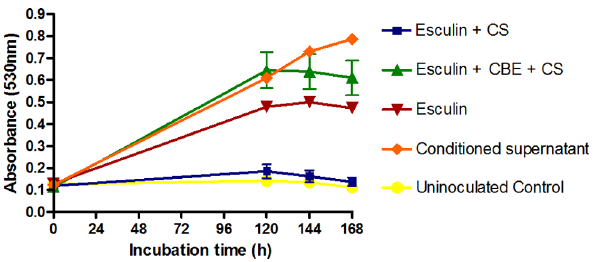
Figure 4. Effect of the b –glucosidase inhibitor Conduritol B epoxide (CBE; 40 m g/ml) on growth inhibition of T. rubrum NCPF0118. Esculin concentration=1704.1 m g/ml; Esculetin concen- tration=696.72 m g/ml. CS – Conditioned supernatant. Conduritol B epoxide (CBE) Concentration=40 m g/ml. The esculetin control inhibited growth for the entire 168 h. All results are representative of triplicate samples from triplicate experiments. Error bars represent the standard deviation of the